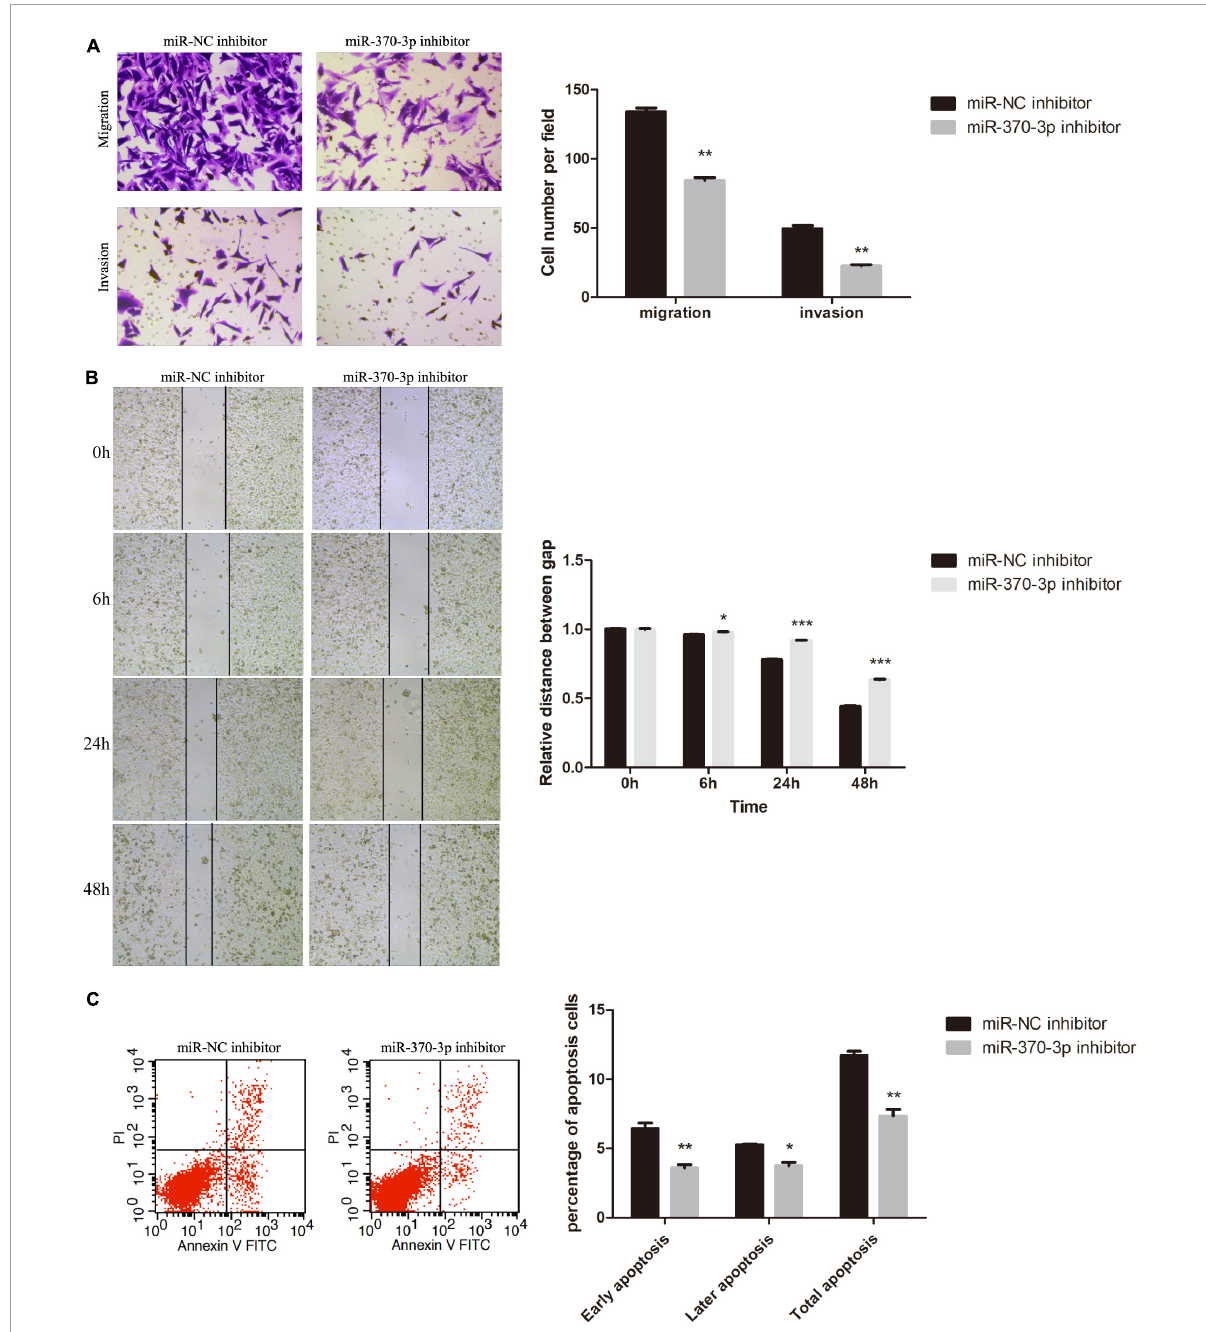
FIGURE8 Effect of hsa-miR-370-3p knockdown on apoptosis, migration and invasion of HTR-8 cells. (A) Representative images and quantification of migration and invasion. (B) Representative images of wound healing assay and the relative distance between gap. (C) Representative images and quantification of apoptosis. * P < 0.05, ** P < 0.01, *** P <